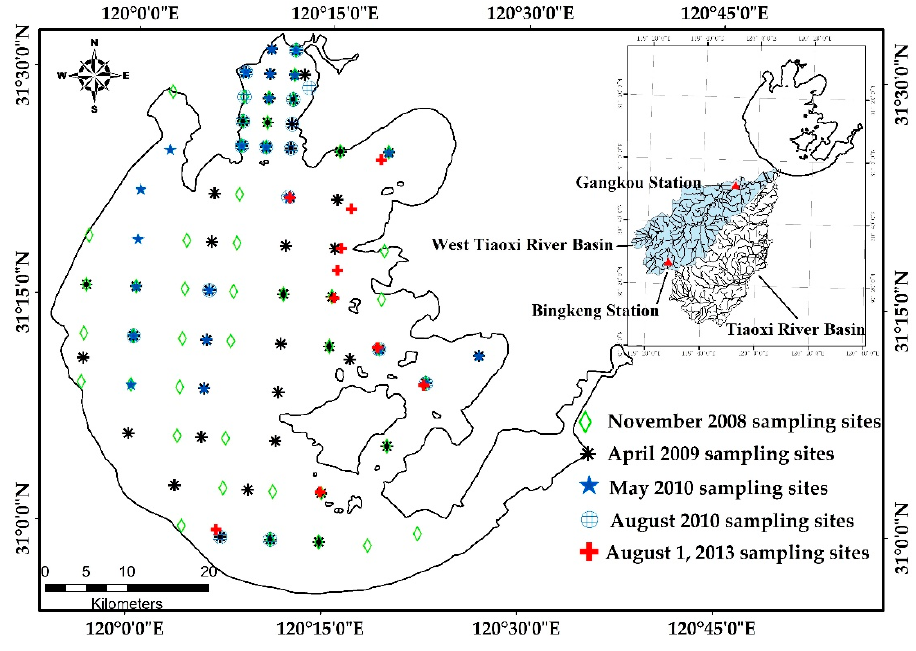
Figure 1. Distribution of sampling sites.